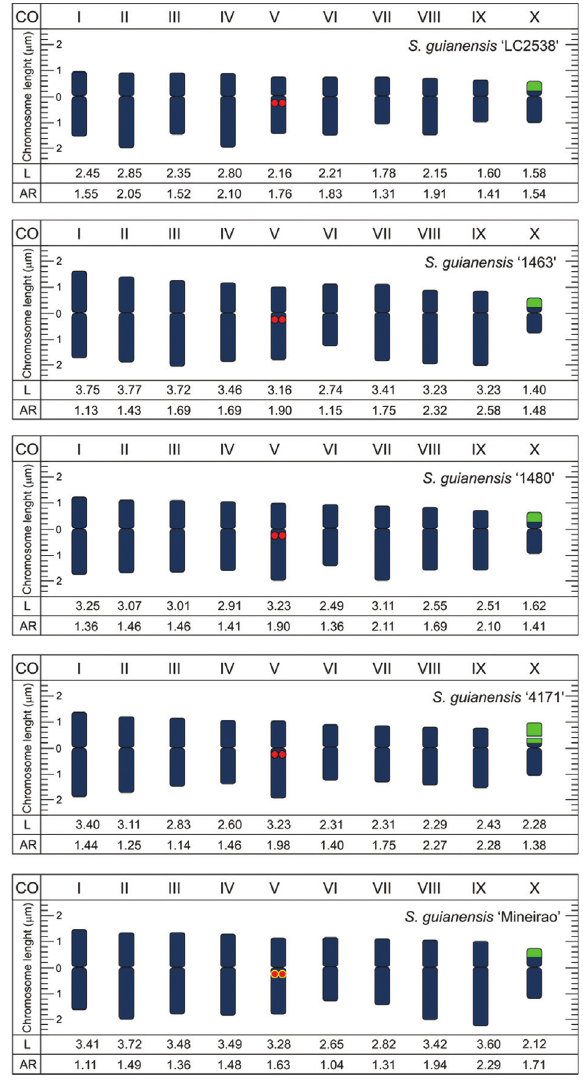
Figure 4 - Idiograms of S. guianensis accessions showing chromosome length (L), arm ratio (AR), 5S (red), CMA bands co-localized with 35S r DNA sites (green), and CMA bands co-localized with 5S